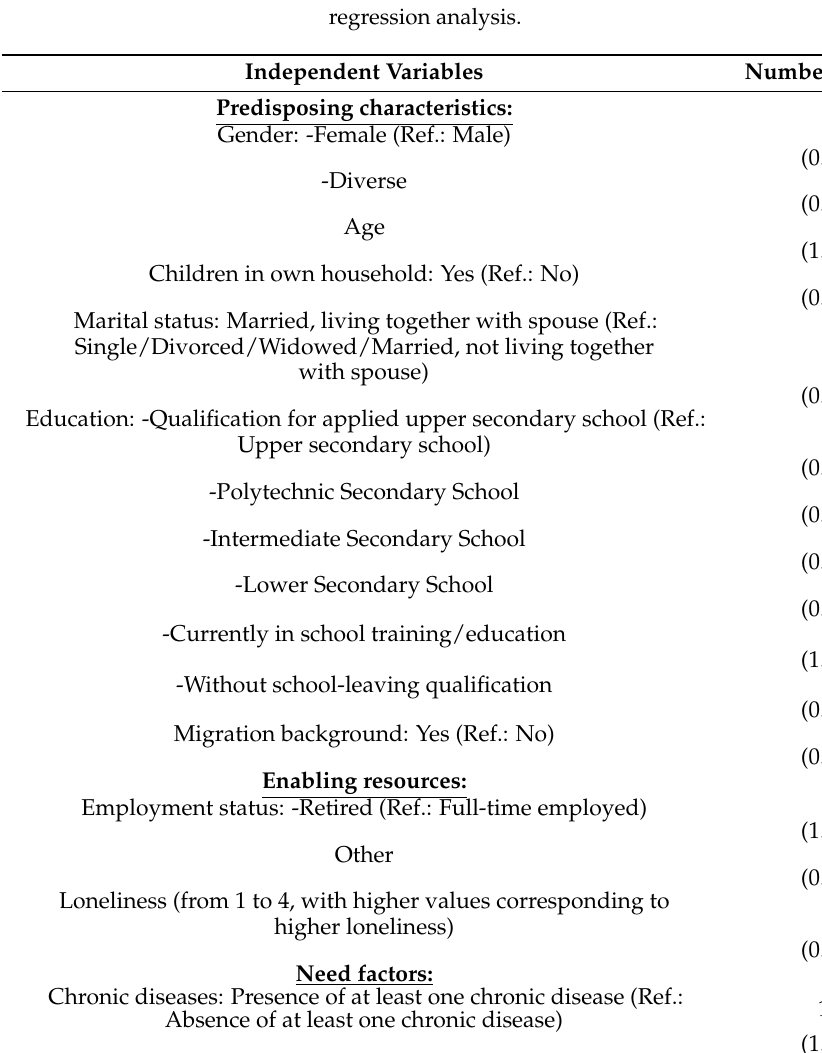
Table 2. Determinants of outpatient physician visits. Results of multiple negative binomial regression